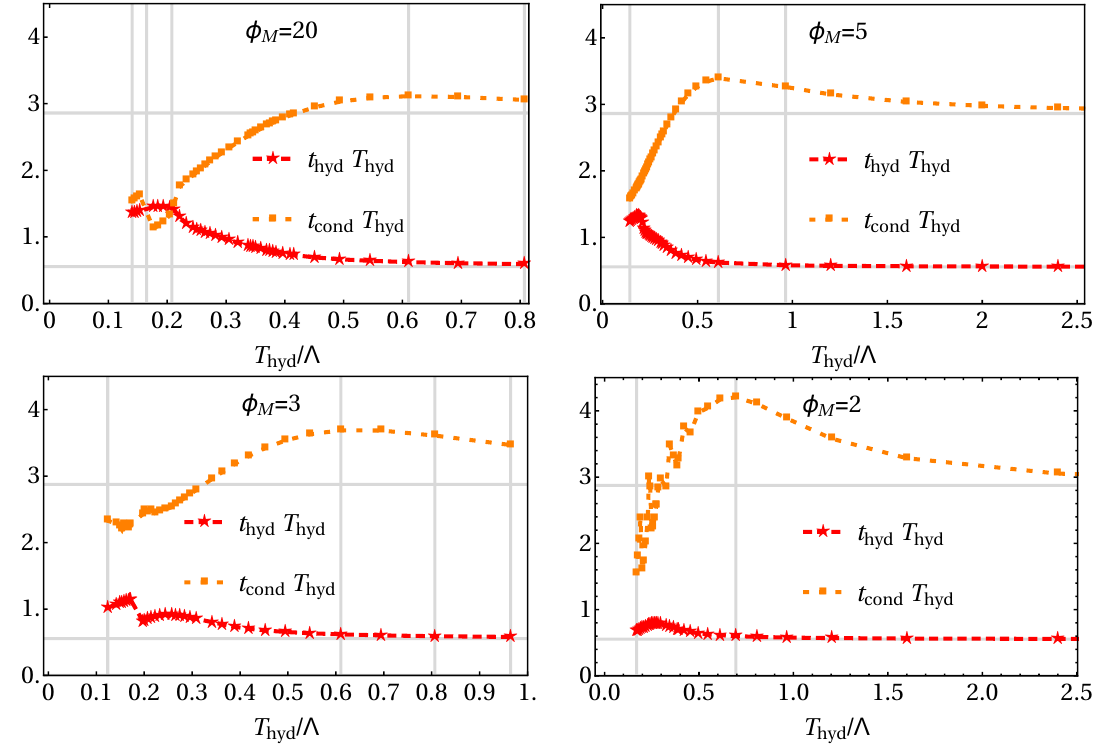
Figure 13 . Condensate relaxation times and hydrodynamization times for collisions with (cid:22)! = 0 : 30 in models with (cid:30) = f 20 ; 5 ; 3 ; 2 g . The bottom horizontal grey line lies at t hyd T hyd = 0 : 56 M and corresponds to the conformal limit of t hyd for 1 = 2 shocks. The top horizontal line lies at t hyd T hyd = 2 : 9 and corresponds to the conformal limit of t cond for 1 = 2 shocks. The leftmost (rightmost) grey vertical line indicates the lowest (highest) temperature that we probed. The other grey vertical lines indicate either points at which t cond = t hyd , points at which the ratio t cond =t hyd is maximal, or points at which t cond T hyd is maximal. The positions of these lines in each panel is as follows. Top left: T hyd = (cid:3) = f 0 : 141 ; 0 : 165 ; 0 : 208 ; 0 : 610 ; 0 : 807 g . The highest temperature in this case is the one at which the ratio t cond =t hyd is maximal. Top right: T hyd = (cid:3) = f 0 : 143 ; 0 : 610 ; 0 : 964 g . Bottom left: T hyd = (cid:3) = f 0 : 124 ; 0 : 611 ; 0 : 807 ; 0 : 965 g . Bottom right: T hyd = (cid:3) = f 0 : 169 ; 0 : 695 g .